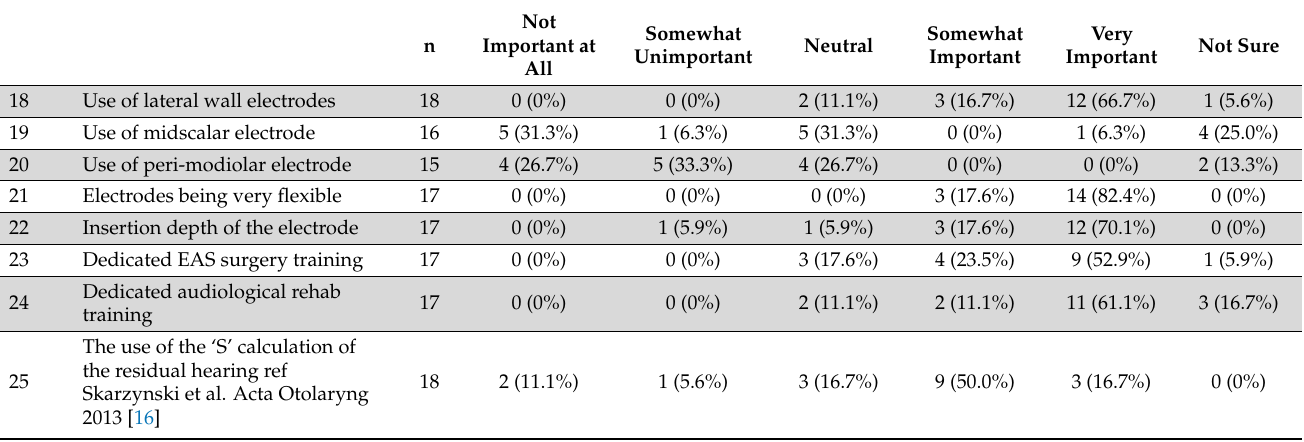
Table 2. Survey responses for the 8 new items. Note: the paper referenced in item #25 is reference [16] in this